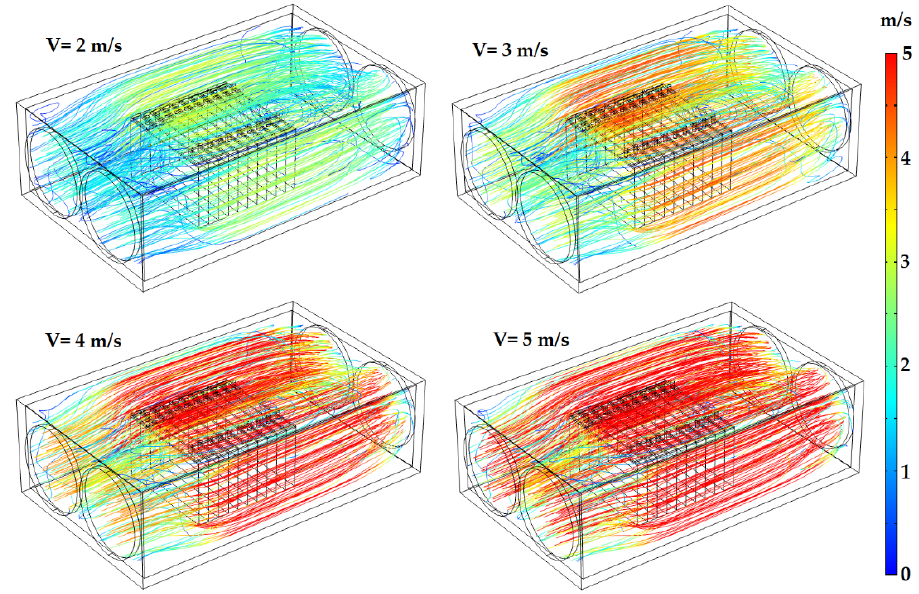
Figure 10. Velocity streamlines for four inlet air velocity case studies. Energies 2021 , 14 , x FOR PEER REVIEW